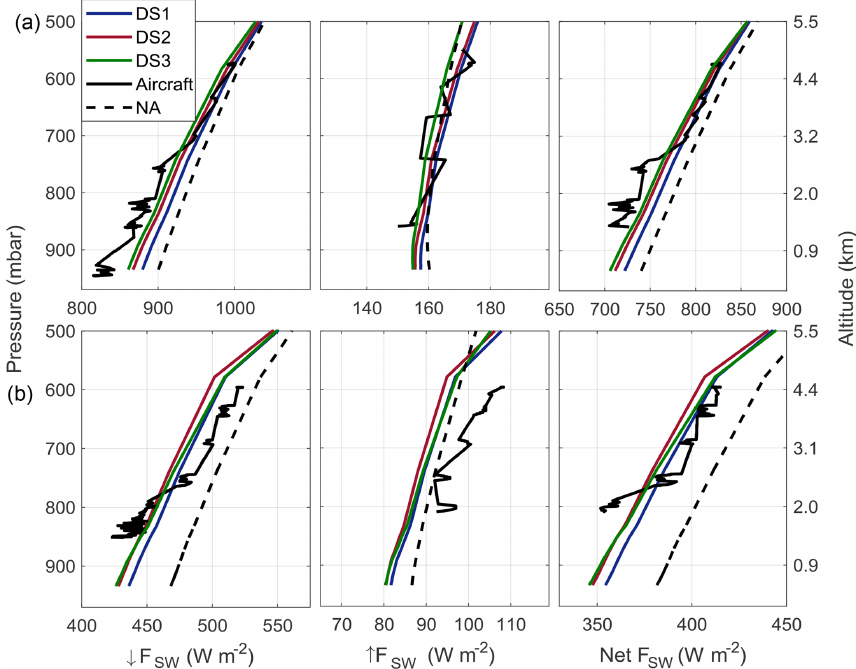
Figure 6. Radiative fluxes for the SW spectral range for 16 June (a) and 17 June (b) simulated with GAME using different input aerosol datasets (DS1 in blue, DS2 in red, and DS3 in green). The black lines are the aircraft in situ measurements distant from about 20km. The black dashed lines represent the radiative fluxes without the aerosol component